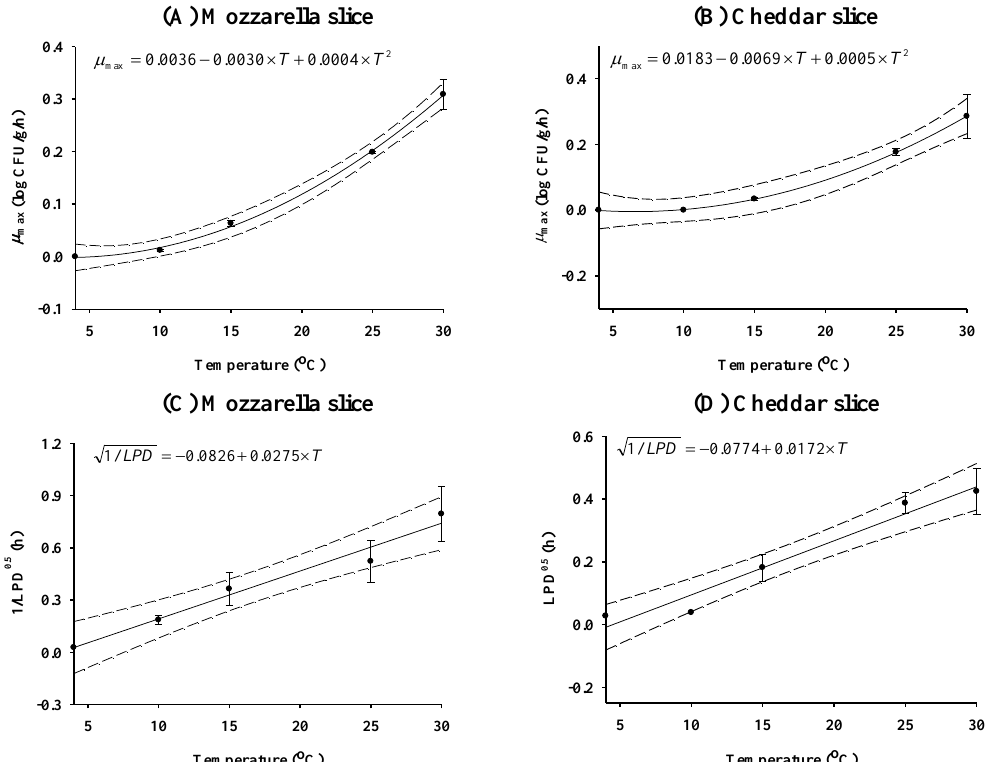
Figure 2. Polynomial equation for  max (A-B) and linear equation for lag phase duration (C-D) developed for Mozzarella slice and Cheddar slice cheeses. ●, observed value; ―, predicted line; ---, 95% confidence interval.